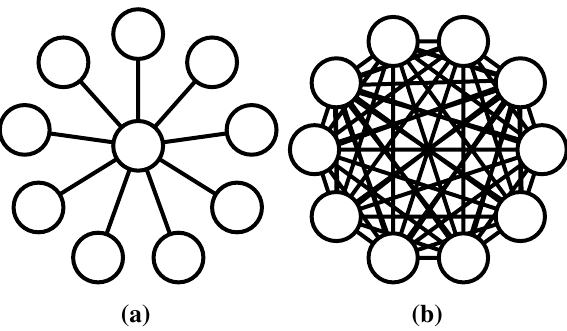
Figure 1. Illustrations of ( a ) a star network and ( b ) a full network, each with ten regions. Circles represent regions, and straight lines represent travel routes between regions.